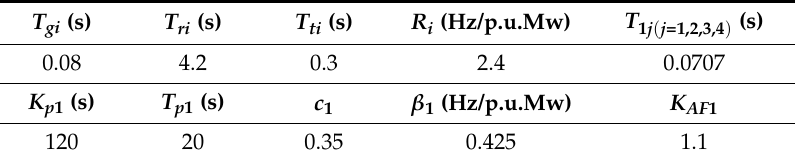
Table 1. Parameters in Control Area 1 of the interconnected power system.